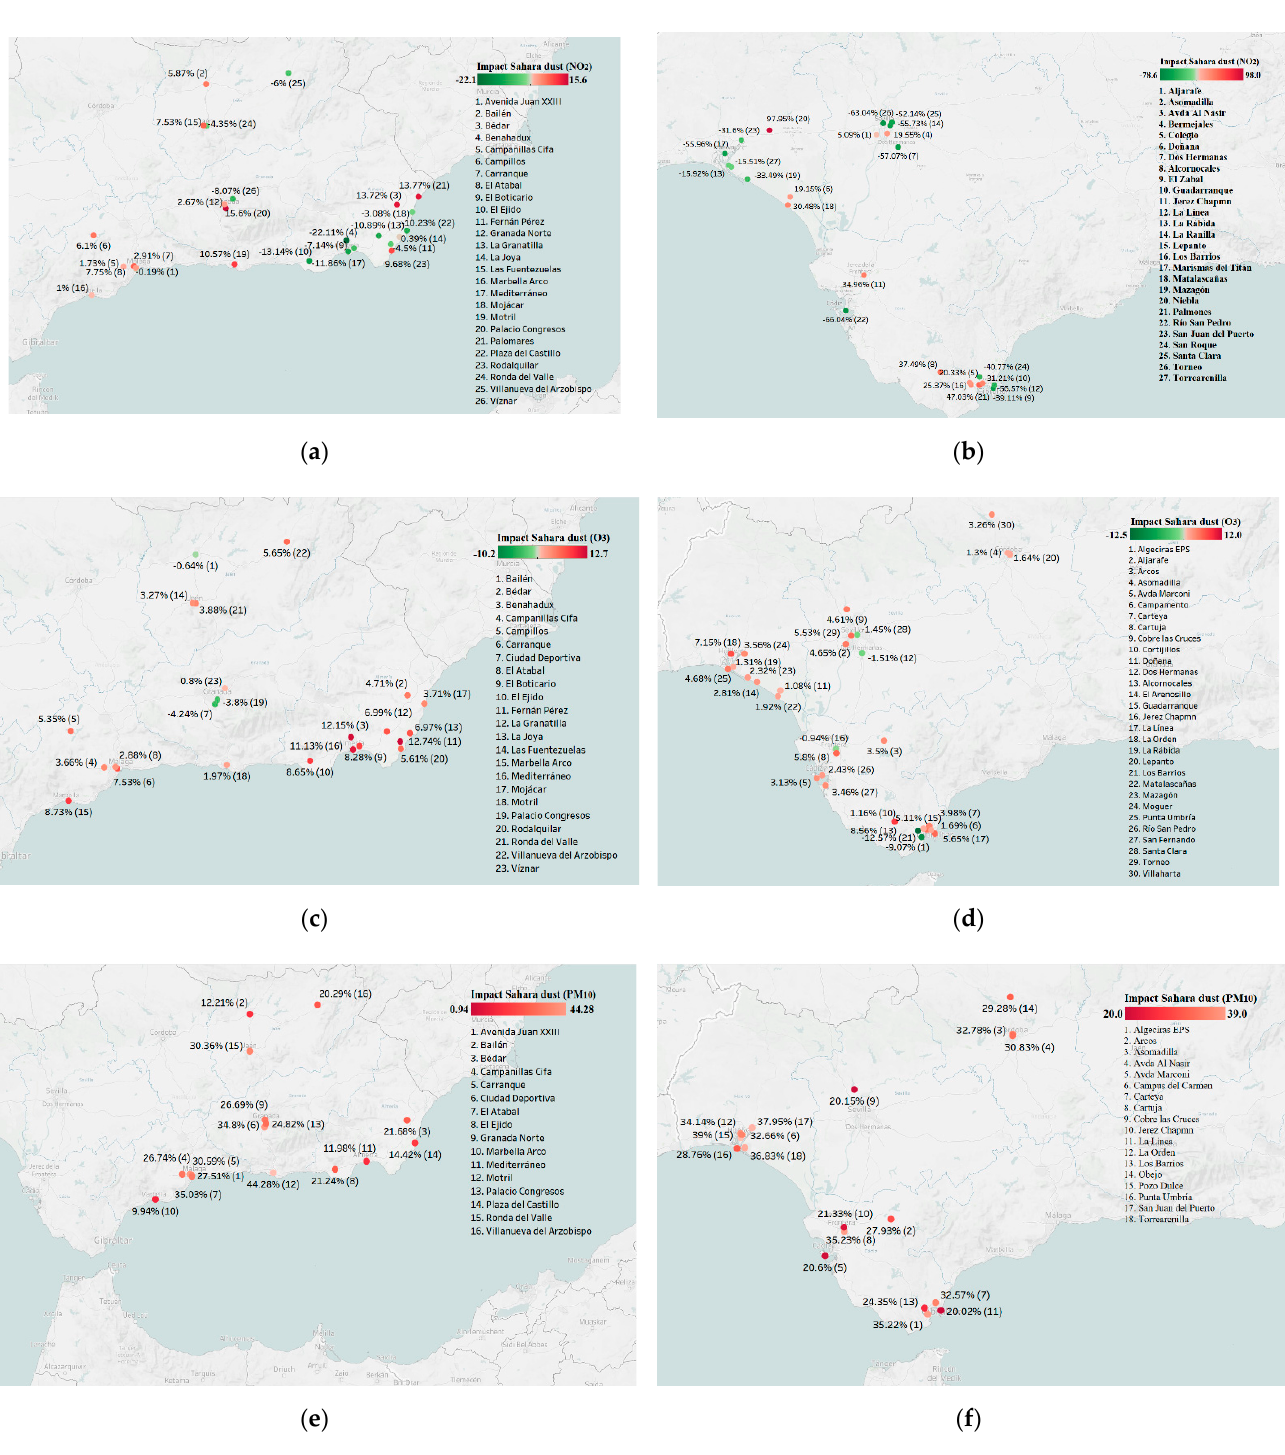
Figure 2. The left and right sides contain the estimates of the Saharan dust effect by air monitoring stations in the SE and SW, respectively. ( a ) Saharan dust intrusion on NO 2 in SE Andalusia; ( b ) Saharan dust intrusion on NO 2 in SW; ( c ) Saharan dust intrusion on O 3 in SE Andalusia; ( d ) Saharan dust intrusion on O 3 in SW Andalusia; ( e ) Saharan dust intrusion on PM 10 in SE Andalusia; ( f ) Saharan dust intrusion on PM 10 in SW Andalusia.